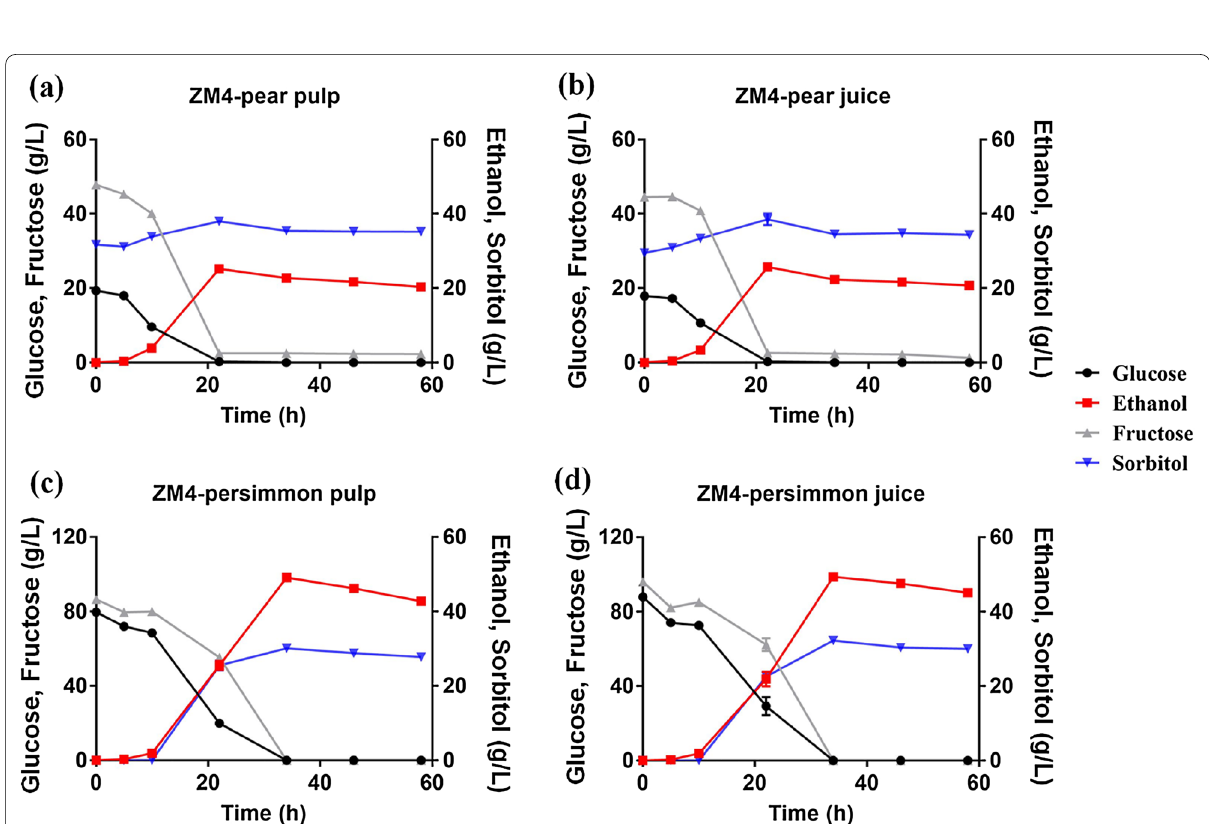
Fig. 2 Concentration changes of glucose (black circle), ethanol (red square), fructose (grey triangle), and sorbitol (blue inverted triangle) during fermentation by Z. mobilis in pear pulp ( a ), pear juice ( b ), persimmon pulp ( c ), and persimmon juice ( d ), respectively. There was no significant difference for Z. mobilis fermentation in both fruit pulp and juice with T -test p -value greater than